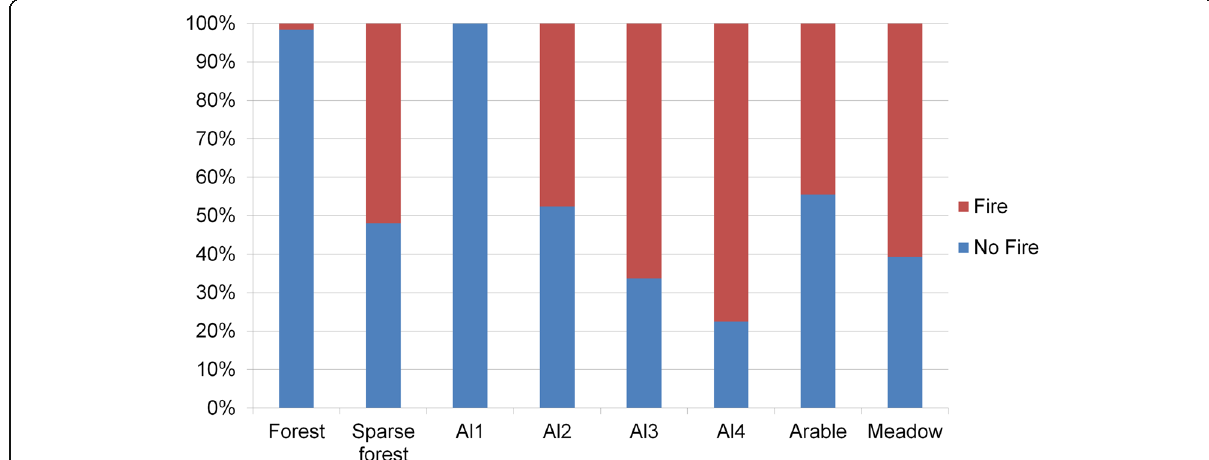
Fig. 6 Percentage of the area affected and unaffected by fire from 1985 to 2014 per land